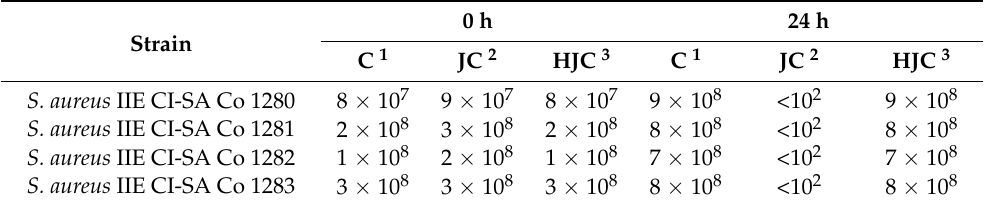
Table 5. Antagonistic activity of LF3872 against S. aureus clinical isolates from the milk of cows with mastitis.